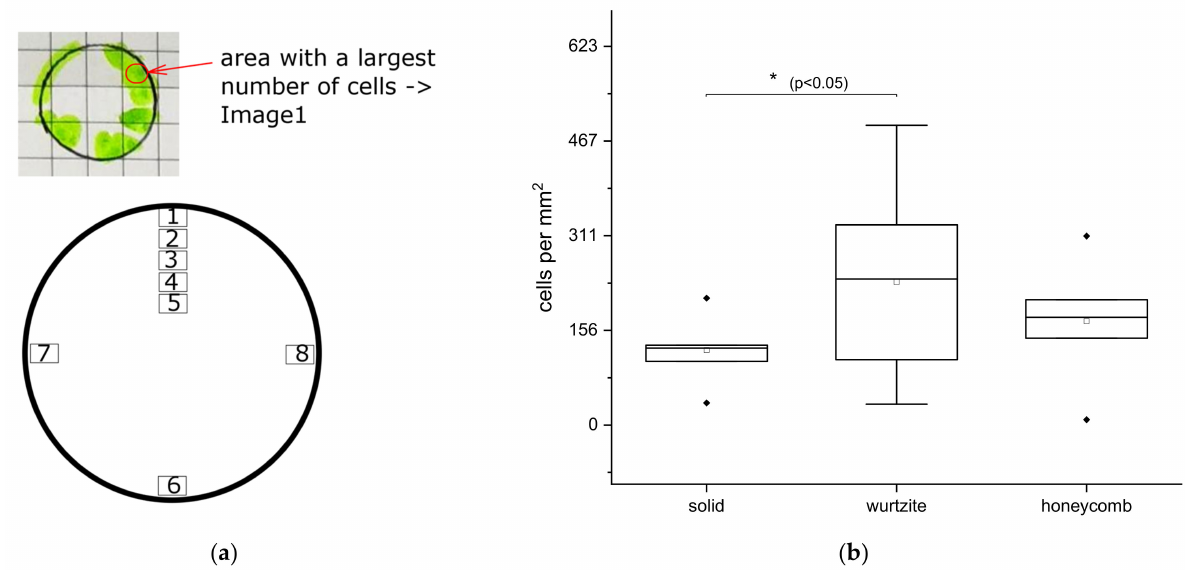
Figure 8. Schematics of 8 analyzed areas on Ti-disks: green areas represent cells on Ti-disks ( a ). Cells were counted inside areas 1–8 ( a ). Number of the cells grown out from bone cylinder onto Ti-disks with different surface textures ( b ). Number of cells was calculated using seven bone cylinders per group and one